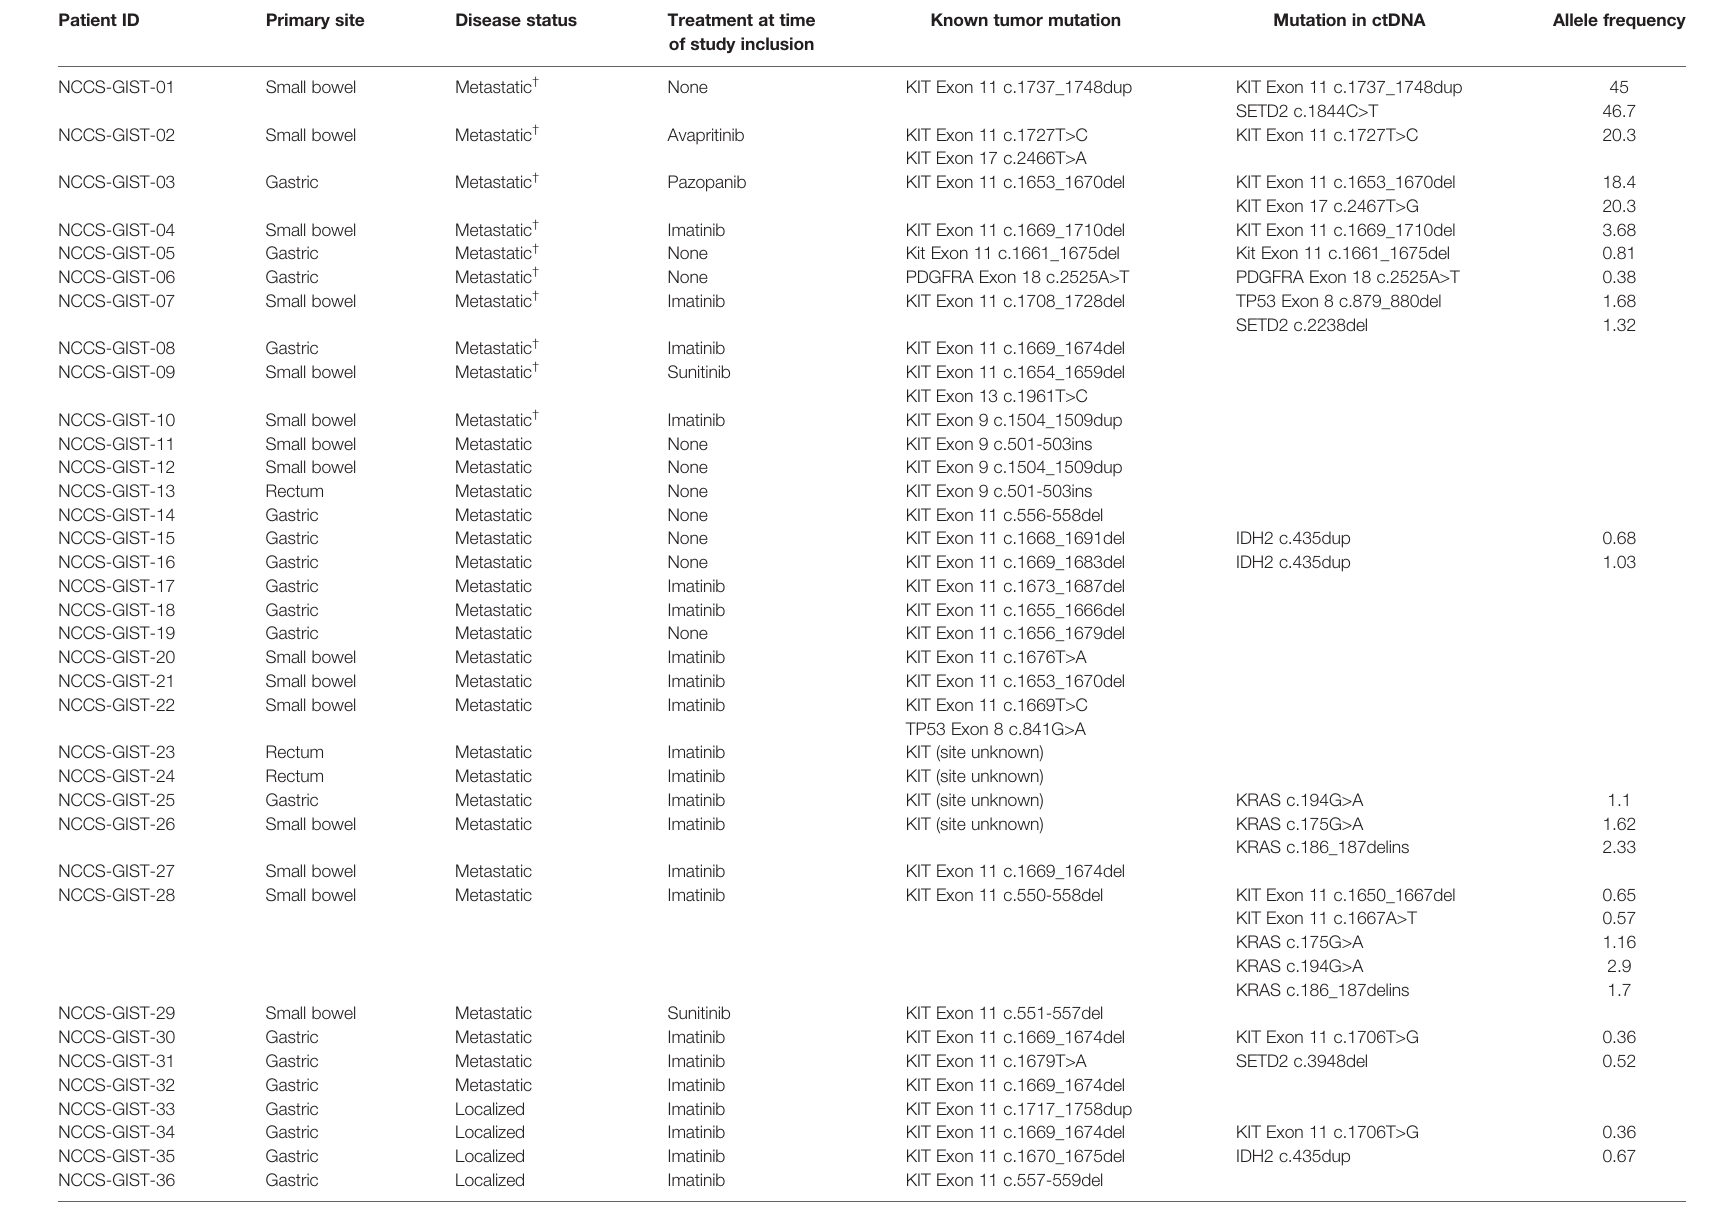
TABLE 2 | Mutational pro fi les of tumor and plasma